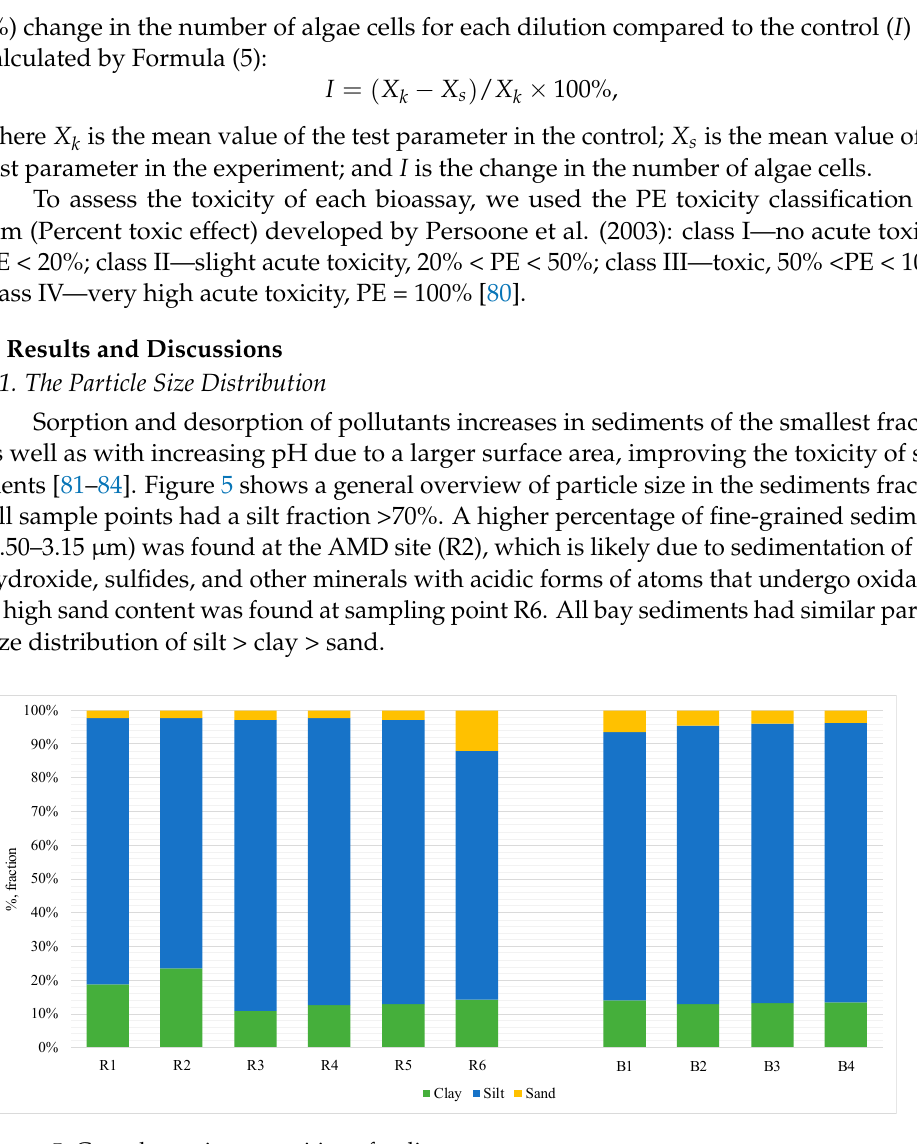
Figure 5. Granulometric composition of sediments.